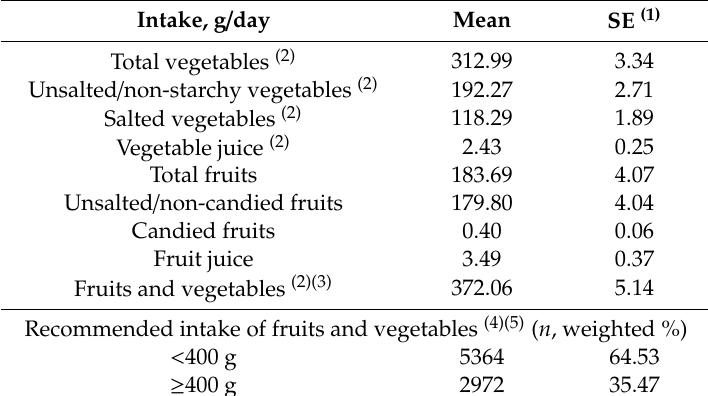
Table 1. Intake of fruits and